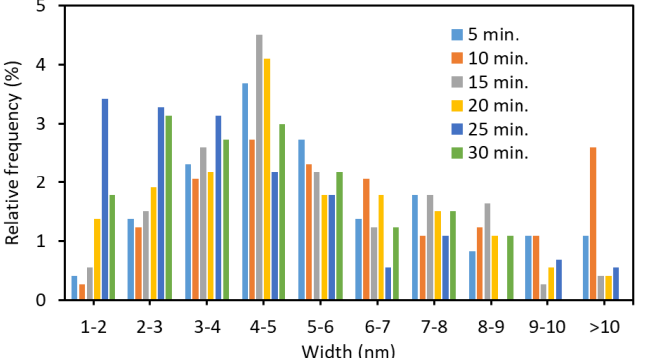
Figure 4. The effect of ultrasonication time at 45 kHz on the distribution of partially deacetylated chitin nanofiber. chitin